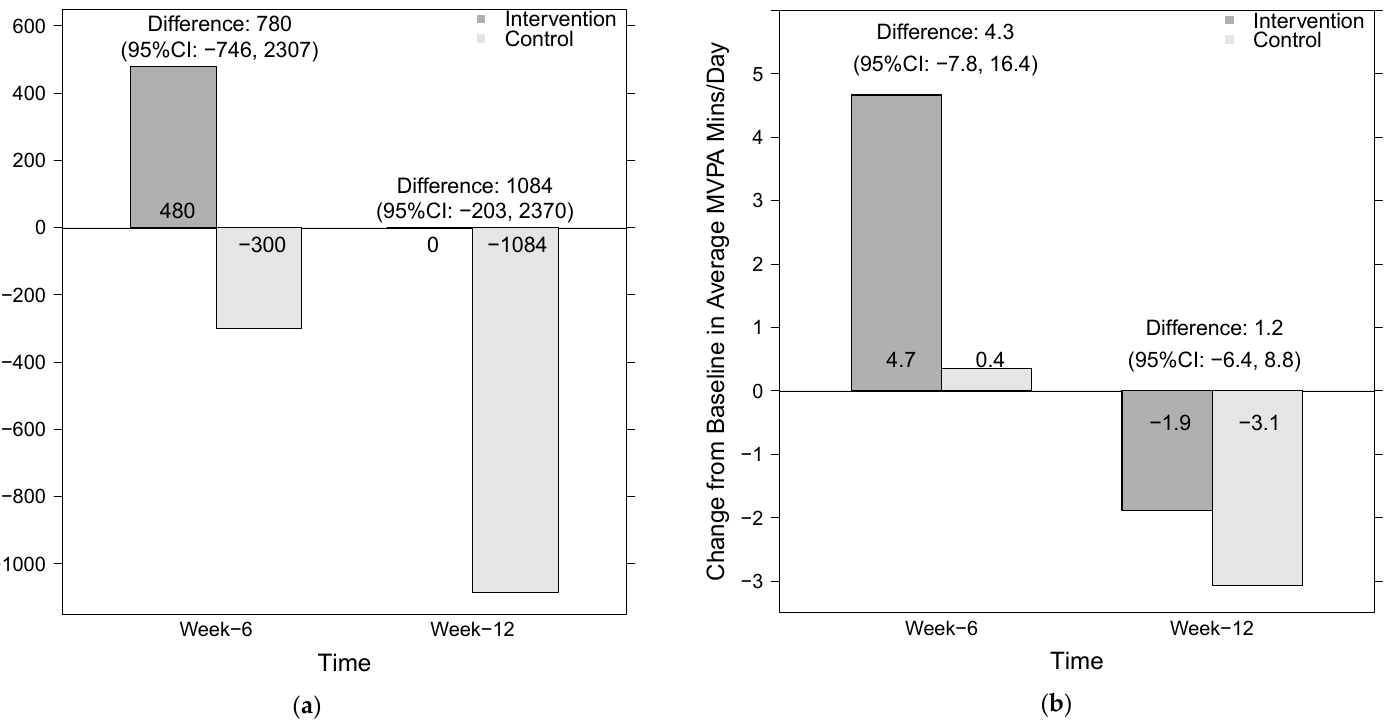
Figure 1. Change in average steps/day ( a ) and moderate-to-vigorous physical activity (MVPA) minutes/day ( b ) among participants in the Stealth Pet Obedience Training (SPOT) pilot study from baseline to 6 and 12 weeks. Analysis restricted to participants with valid ActiGraph data at both baseline and timepoint of interest: 16 intervention participants and 18 control participants at week 6, and 16 intervention participants and 17 control participants at week 12.